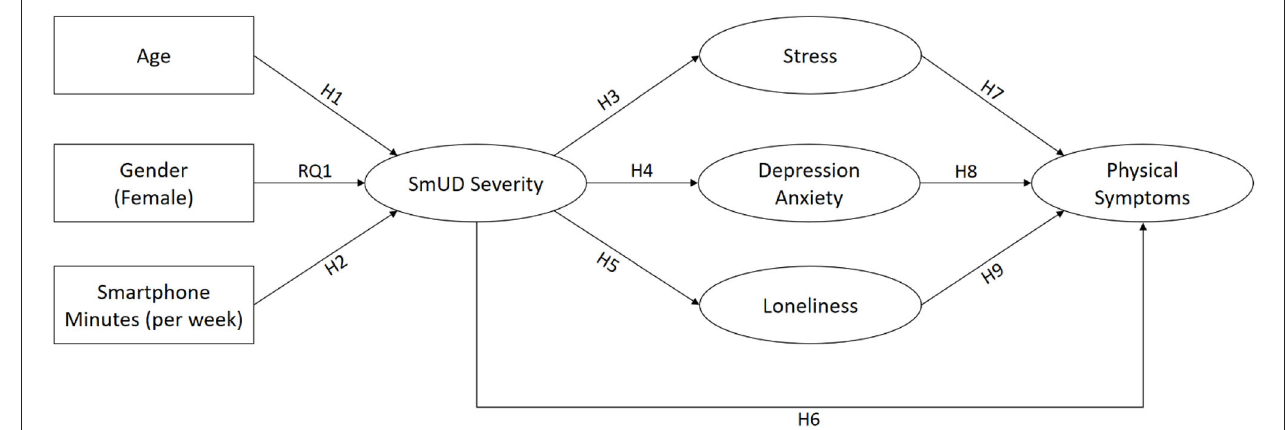
FIGURE 1 | Predicted structural model labeled with hypotheses and research questions. SmUD, smartphone use